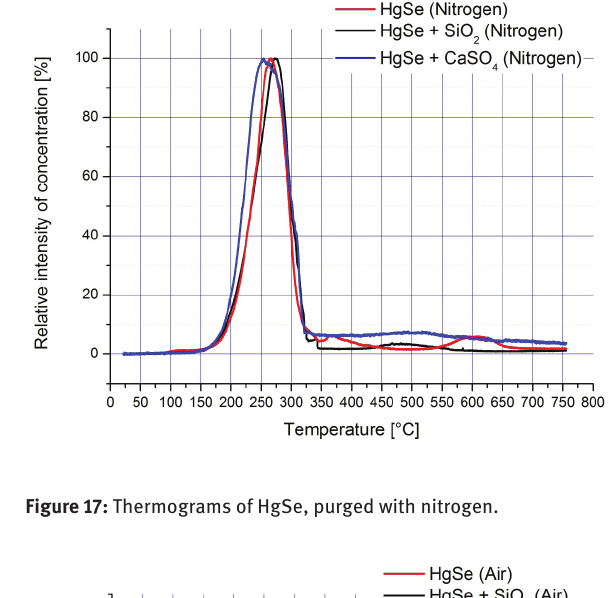
Figure 16: Thermograms of HgS mixtures, obtained by MS.